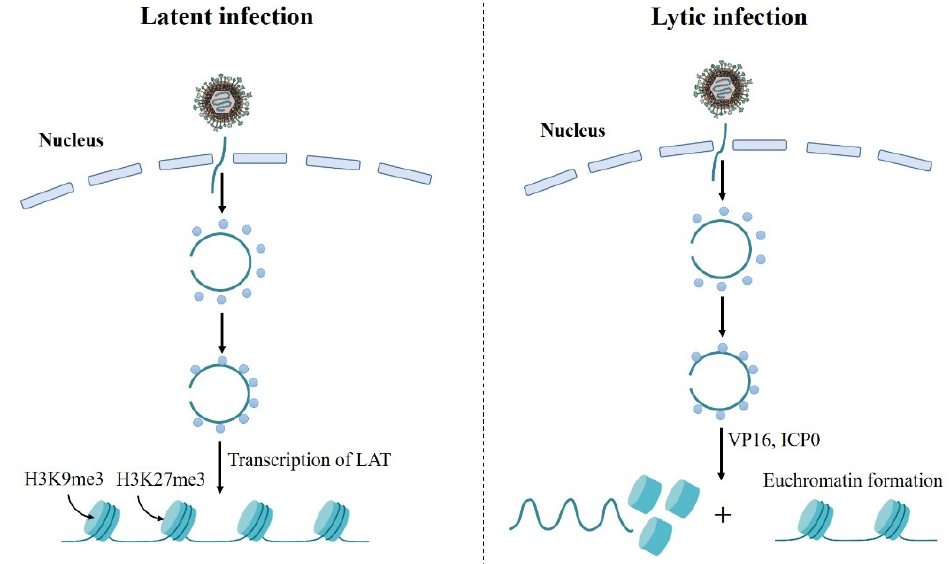
Figure 2. Chromatin can play important roles in regulation of alphaherpesvirus latent and lytic infection. During latent infection of neuronal cells, the virus capsid is transported to the nuclear pore where viral genome is released into the nucleus. When the genome enters the nucleus, it can be rapidly circularized and complexed with histones. Then the LAT is expressed and it promotes the association of heterochromatin marks on the viral genome ( left panel ). During lytic infection of epithelial cells, the virus capsid is also transported to the nuclear pore where the viral genome is released into the nucleus. In the nucleus, viral genome rapidly circularizes and becomes associated with histones. Then VP16 can decrease histone association with viral IE genes and increase euchromatin marks on the remaining histones. ICP0 can be expressed and it promotes the same processes as VP16 on the viral genome ( right panel ).